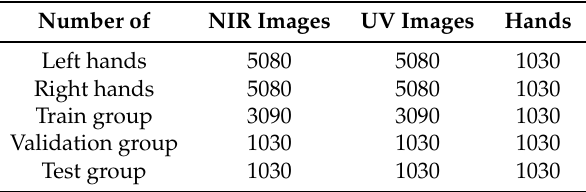
Table 1. Detailed database